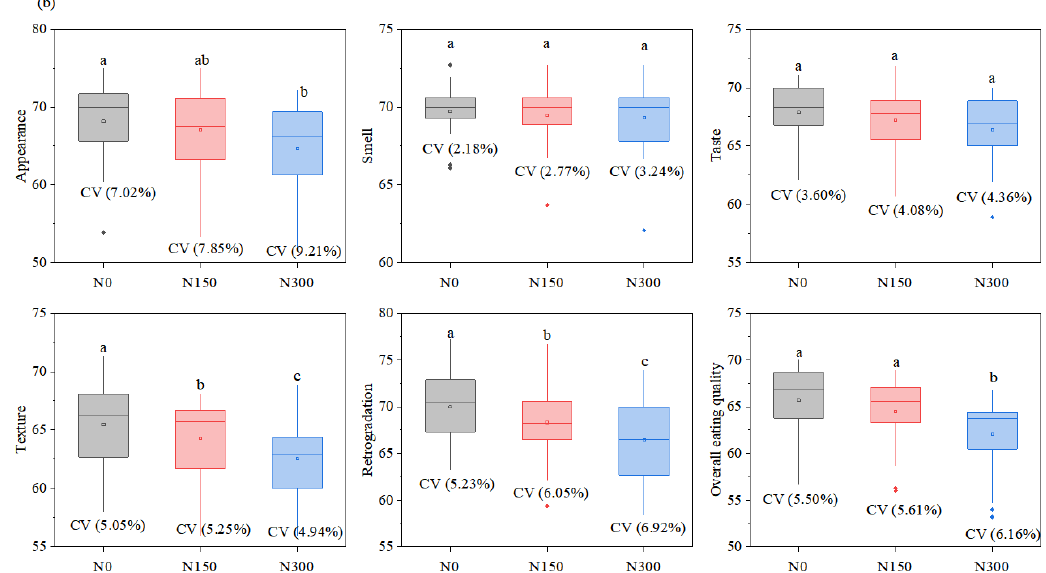
Figure 3. Distribution chart of eating quality for hybrid indica rice varieties ( a ) and inbred japonica rice varieties ( b ) with different nitrogen levels. The values of different lowercase letters refer to significant differences at p < 0.05 among different nitrogen levels. The CV value refers to the coefficient of variation. N0, N150, and N300 refer to treatments with 0 kg ha − 1 , 150 kg ha − 1 , and 300 kg ha − 1 applied. Table 2. Eigenvalue and contribution of each comprehensive index and loading matrix of each component for qualities of hybrid indica